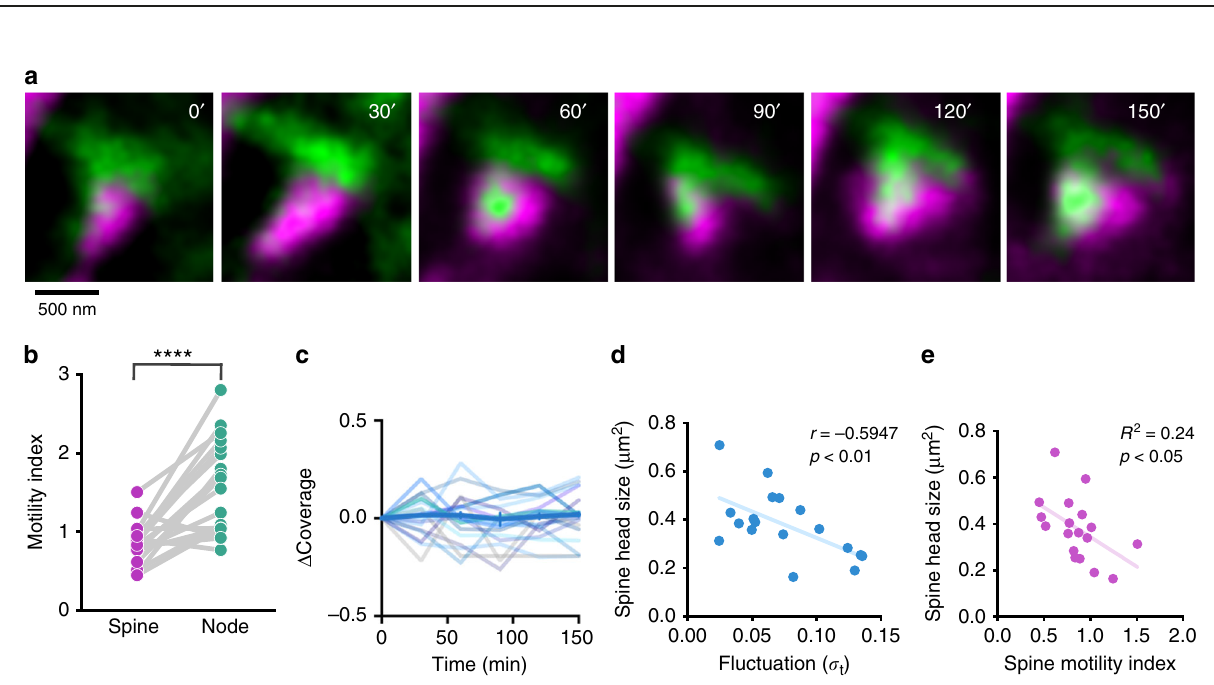
Fig. 3 Majority of spines are contacted by nodes. a Two-color STED image of morphological interaction between astrocytic spongiform domain (green) and a dendrite (magenta). b Images of spines contacted by nodes, shafts, and spines lacking an astrocytic structure in their vicinity. c Percentage of spines contacted by nodes, shafts, and spines lacking an astrocytic structure in their vicinity. The majority of spines are contacted by at least one node ( n = 188 spines from 21 slices). d Image of extracellular space (black) surrounding a synapse (gray) and astrocyte (yellow). Right image indicates the putative identity of the synaptic components. e Frequency distribution of node area. Nodes were highly variable in size ( n = 103 nodes from 21 slices). f Correlation between node area and spine head area. Node area was strongly positively correlated with spine head area ( n = 103 structures from 21 slices; Spearman r = 0.669, **** p (two-tailed) < 0.0001). g Frequency distribution of fraction of spine coverage by astrocytic node, showing that spine surfaces were mostly node-free ( n = 103 spines from 21 slices). h Correlation between coverage fraction and spine head area. Large spines had similar coverage fractions as small spines ( n = 103 spines from 21 slices; Spearman r = 0.086, p (two-tailed) = 0.38). i Two-color STED image of morphological interaction between astrocytic spongiform domain (green) and an axon (magenta). j Images of boutons contacted by nodes and boutons lacking an astrocytic structure in their vicinity. k Percentage of boutons contacted by nodes and boutons lacking an astrocytic structure in their vicinity. Node-contacted boutons account for the majority of boutons ( n = 35 boutons from 5 slices). l Correlation between node area and bouton head area. Bouton area was positively correlated with node area ( n = 35 structures from 7 slices; Spearman r = 0.5689, *** p (two-tailed) = 0.0004). m Correlation between fraction of bouton coverage by astrocytic node and bouton area. Large boutons had similar coverage fractions as small boutons ( n = 35 boutons from 5 slices; Spearman r = 0.2874, p (two-tailed) = 0.0941).